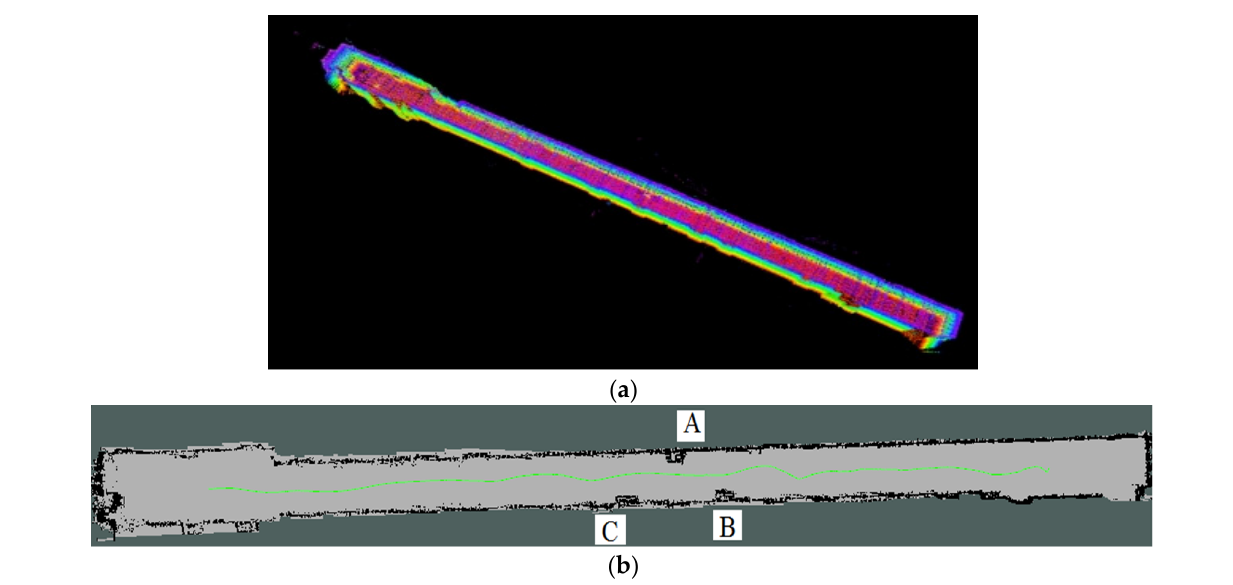
Figure 16. Constructed map of underground coal mine simulation scenario: ( a ) the point cloud map; and ( b ) 2D occupancy raster map.